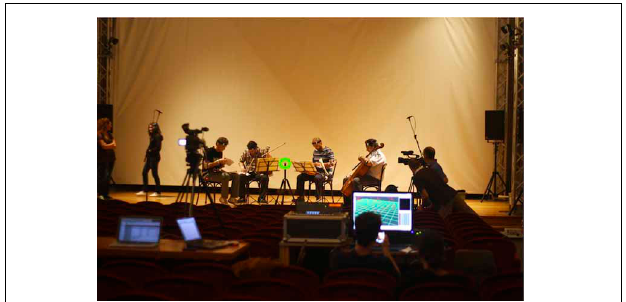
FIGURE 1 | The multimodal setup for the experiment, showing motion capture, videocameras, and environmental microphones. Each musician wears markers for motion capture. Piezoelectric microphones are in the body of the instrument. Note the position of the SQ ear represented by the optical reflector placed on the tripod situated in the center of the quartet, equidistant from the four musicians.